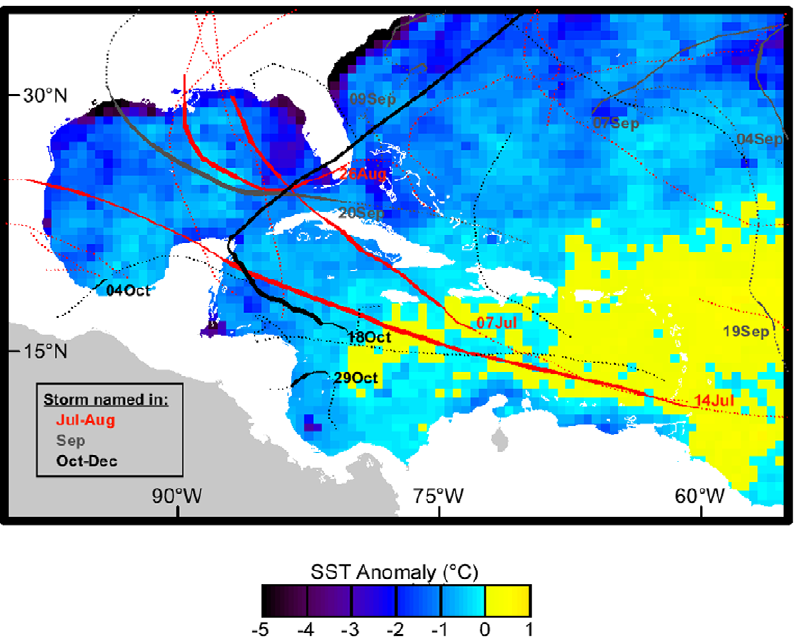
Figure 5. Thermal stress and hurricanes during the 2005 Caribbean bleaching event. Minimum observed SST anomaly for May-December 2005, overlaid with storm tracks (solid: hurricane, thickness denotes strength category; dotted: tropical storm; red: June-August; gray: September; black: October-December). Dates indicate initial date of hurricane formation. The large yellow region in the eastern Caribbean remained warmer than usual throughout this period.